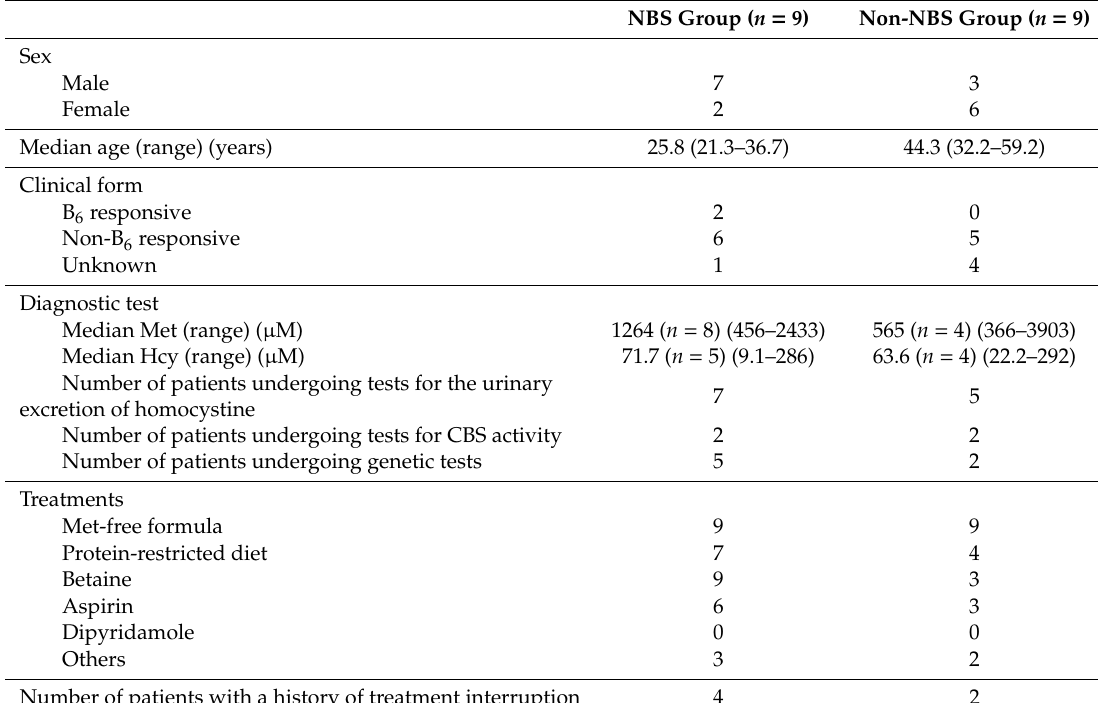
Table 1. Overview of the participating Japanese patients with